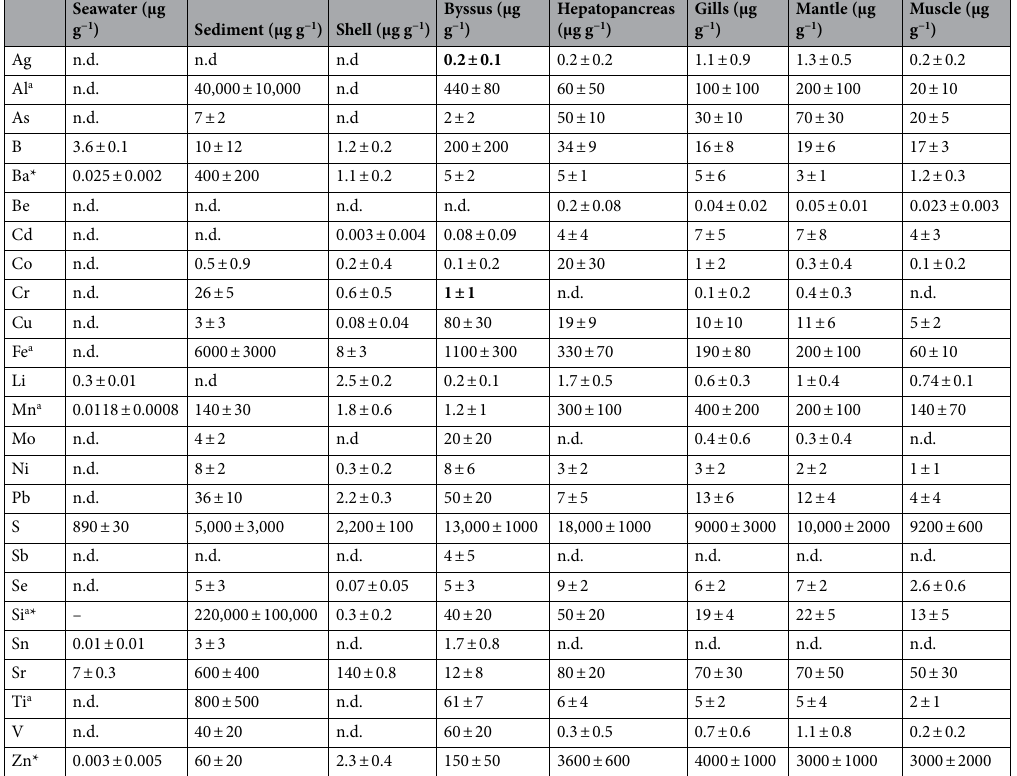
Table 1. Average element content in the sample collected (A and B considered as a unique set). In bold the cases where site A and site B were significantly different (T-test, p = 0.05). Hg and Tl were analyzed and not detected in any specimen. n.d . not detected. a Sediment data were collected as the corresponding oxide. *Comparable amount was found in the shell control sample. –Not